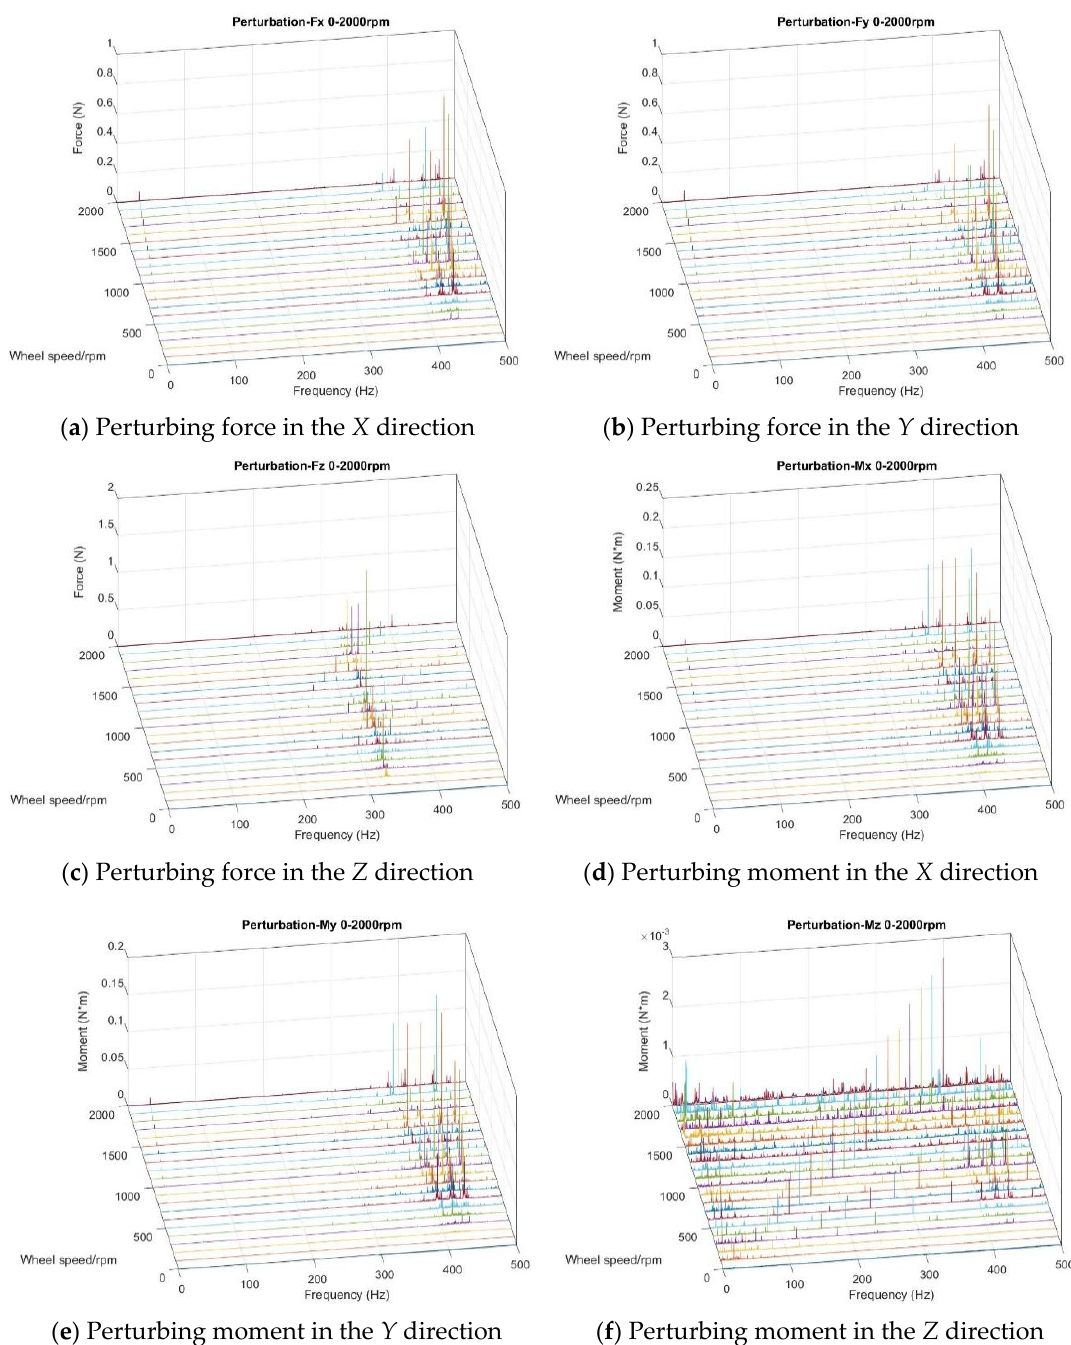
Figure 4. Waterfall plot of perturbations in each degree of freedom (DOF).